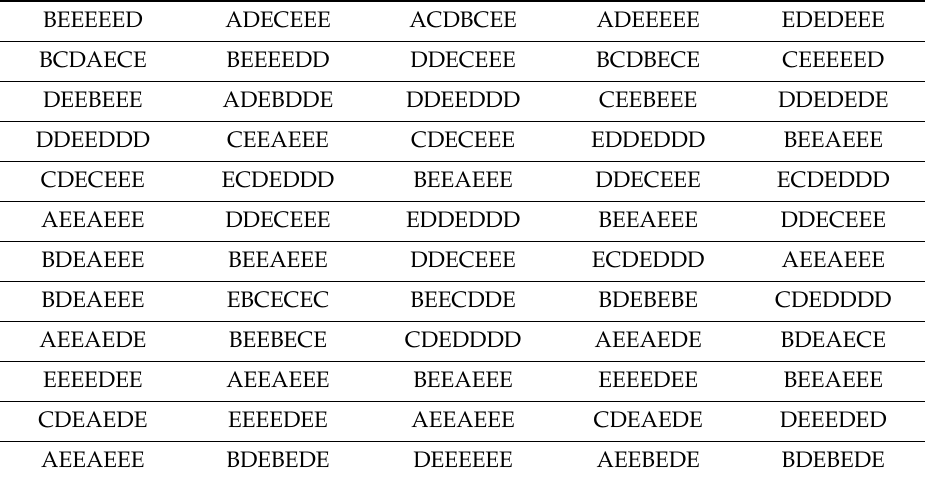
Table 5. Fuzzy modeled output for two-minute duration of PPG signal in CVD